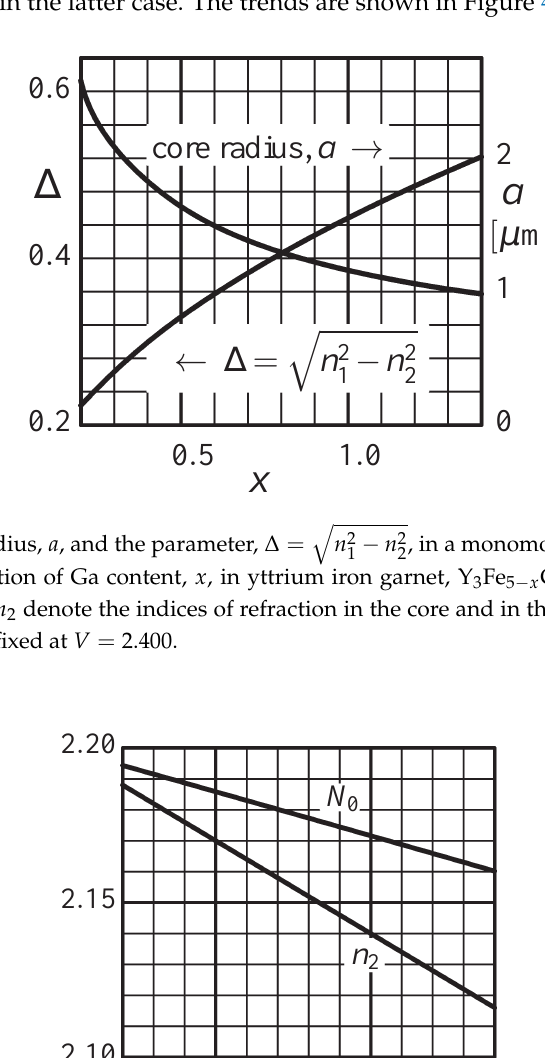
Figure 3. The effective guide index, N 0 and the refractive index, n 2 , of the cladding in a monomode isotropic dielectric cylindrical waveguide as a function of Ga content, x , in Y 3 Fe 5 the